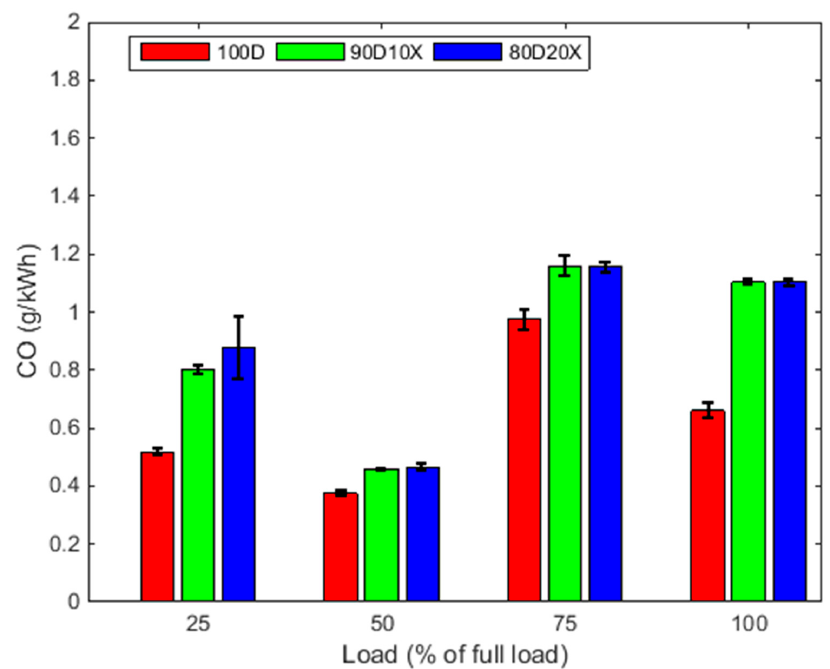
Figure 9. Brake specific CO emission with engine loads for diesel and DOP blends.